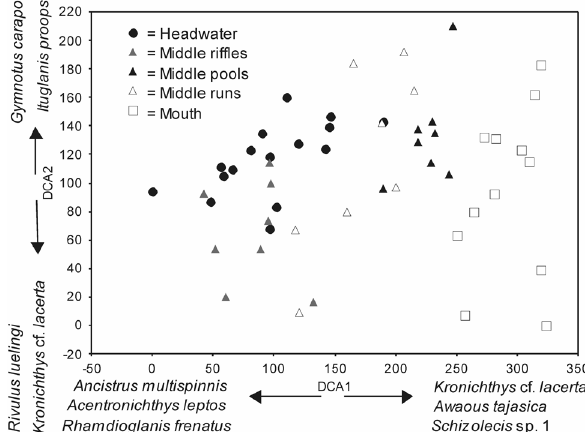
(Eigenmann & Norris, 1900)), were more abundant in pools, while fast-current dwelling (i.e. Characidium spp., A. leptos and A. multispinnis ), were more abundant in riffles. Runs tended to present intermediate abundance for most of the species. For mesohabitat fish structure, the first DCA axis retained ( λ 1 = 0.49), explained 33% of total variance, segregating pools (posi- tive scores) from riffles (less positive scores) (Fig. 6). Synbranchus marmoratus, S. barbatus and P. harpagos were positively correlated with DCA1, while A. leptos , A. multispinnis and C. pterostictum were negatively